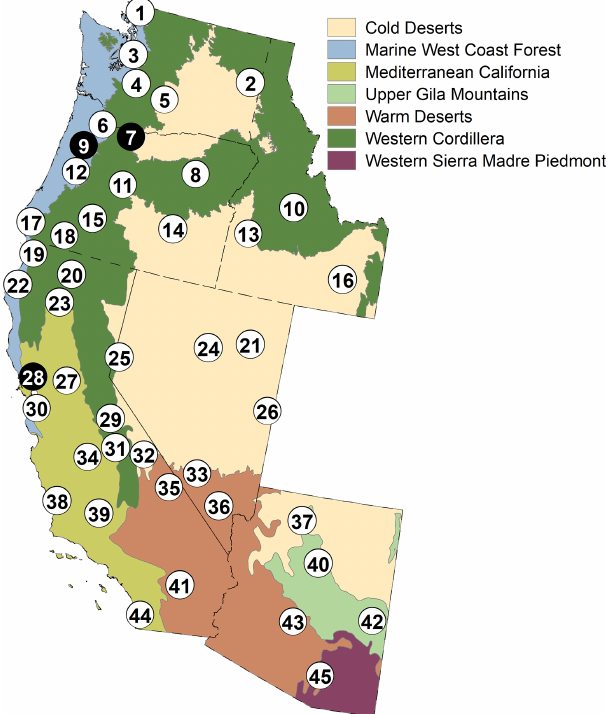
Figure 1. Study area showing a map with the six states of WA, OR, ID, CA, NV, and AZ. Also shown are the seven EPA Level II Ecoregions (https://www.epa.gov/eco-research/ ecoregions-north-america, last access: 3 June 2021) and 45 loca- tions identified by numbered circles with three case study locations in black circles (Table 2). State boundaries are indicated by black dashed